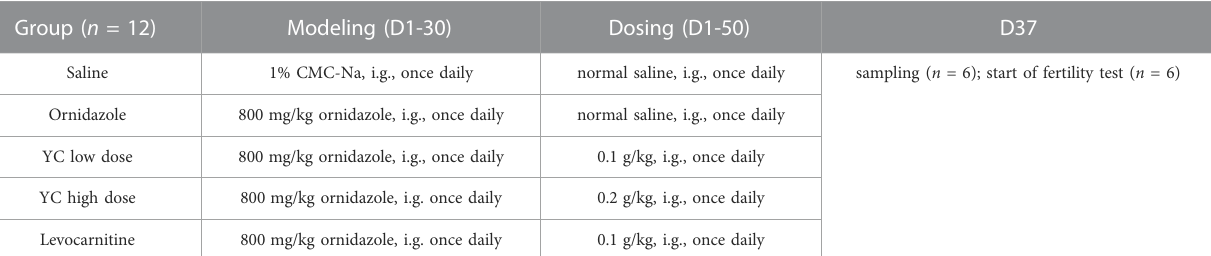
TABLE 1 Modeling and dosing